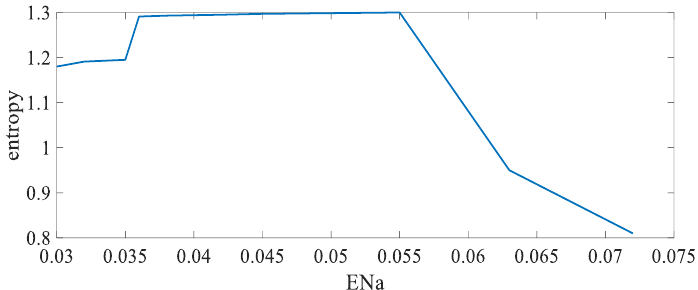
Figure 3. Changing E n by the variation in E Na Figure 3. Changing 𝐸 𝑛 by the variation in 𝐸 𝑁𝑎 .